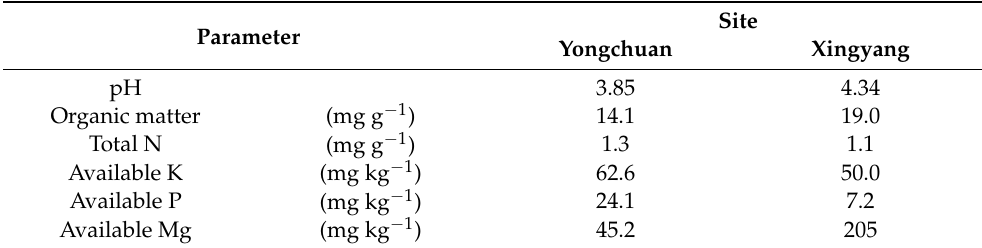
Table 1. Selected soil properties of the experimental tea plantations in Yongchuan, Chongqing, and Xingyang, Henan province. Parameter